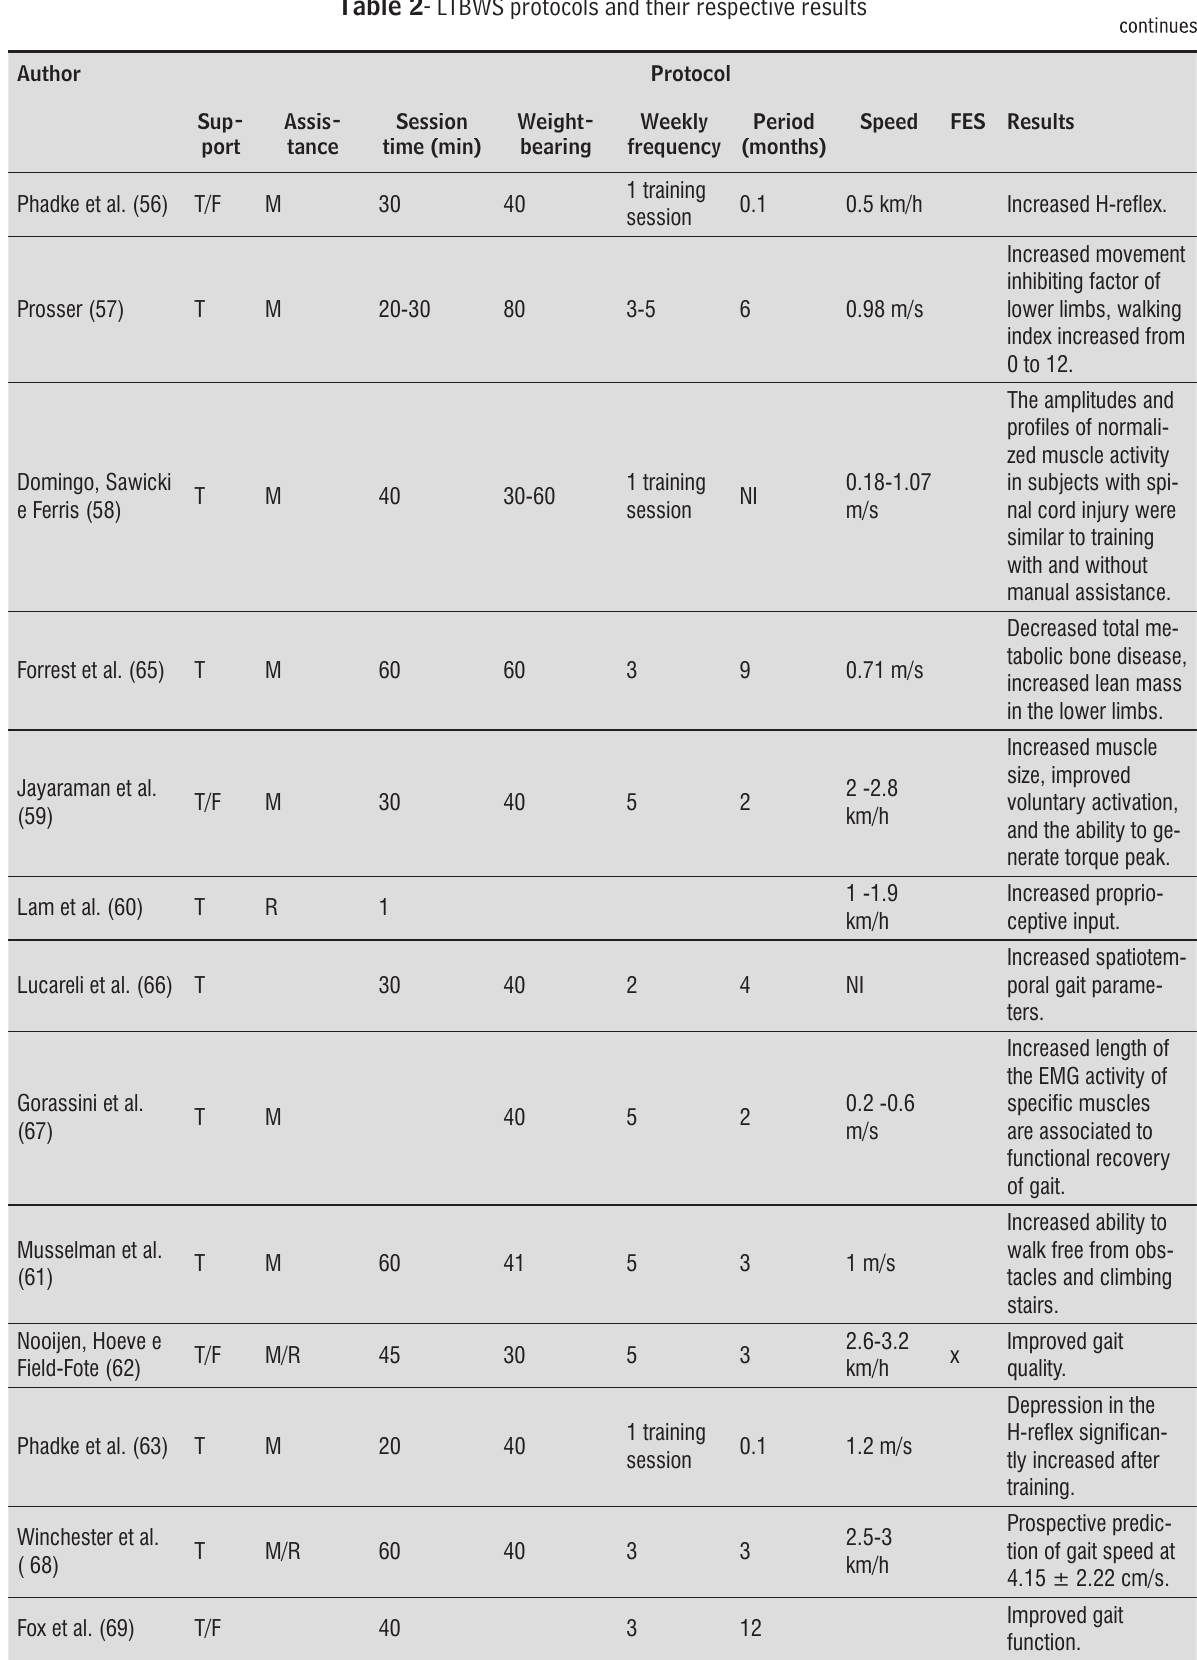
Table 2 - LTBWS protocols and their respective